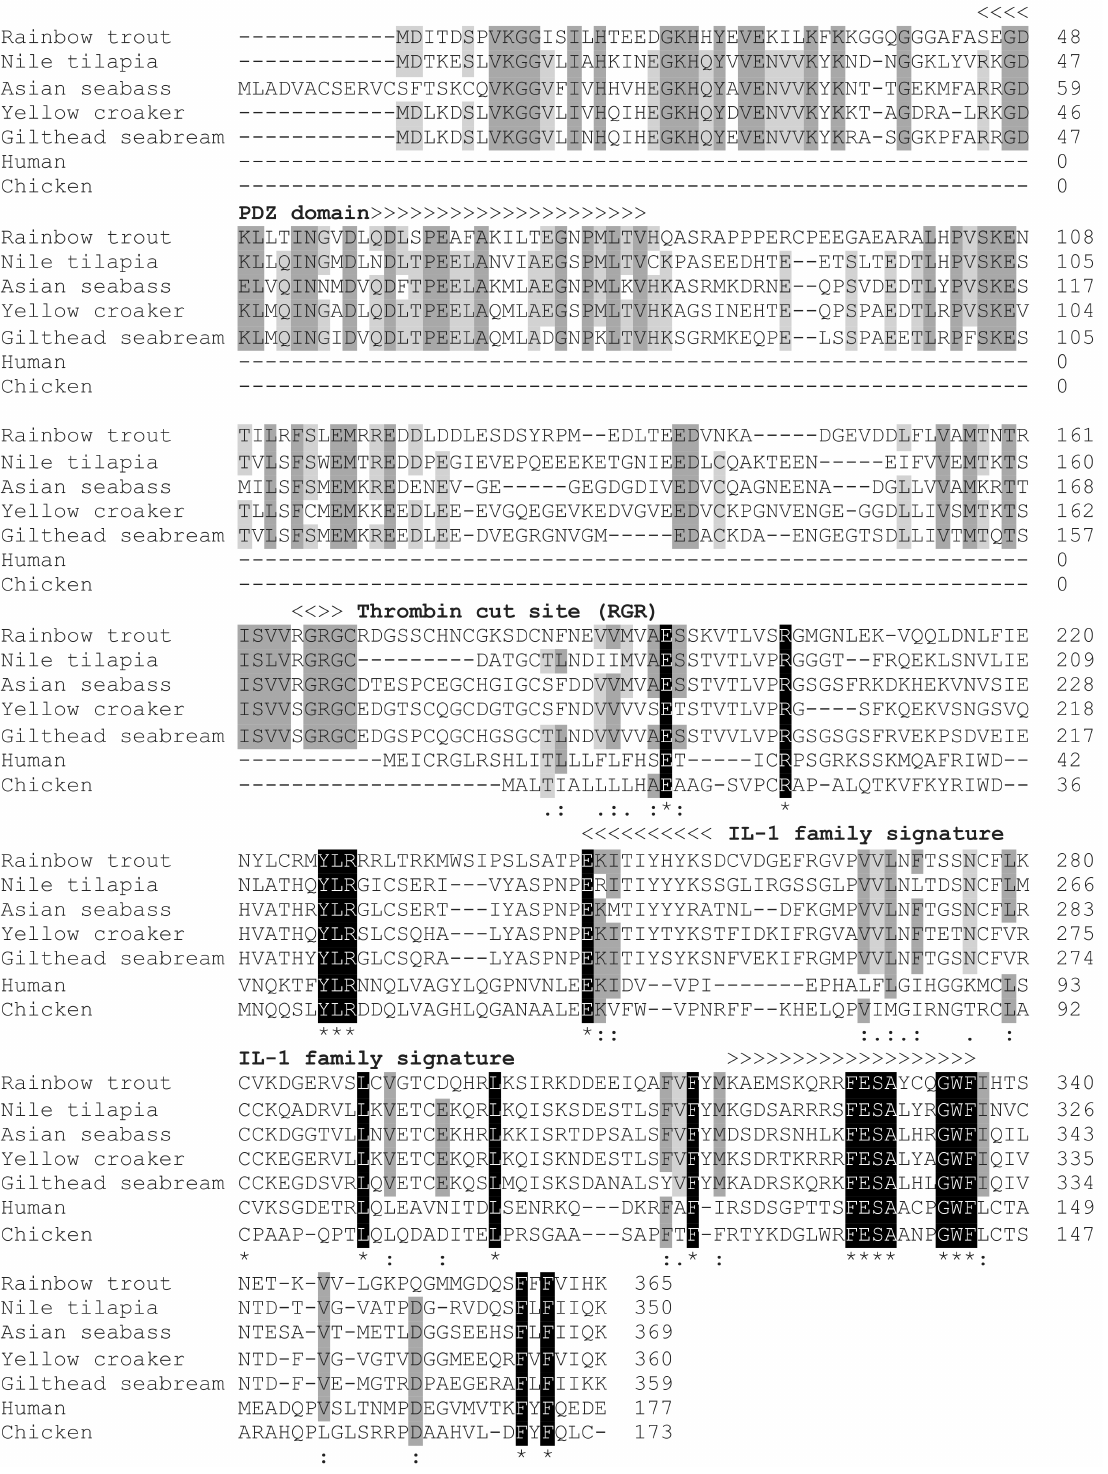
Figure 2. Multiple alignments between the known nIL-1Fm sequences in various vertebrates and the deduced Nile tilapia nIL-1F gene. Asterisks (*) indicate amino acid residues that are identical to those in the Nile tilapia. Dot ( . ) and colon ( : ) indicate positions of similar amino acid residues that are similar sequence. Dashes ( - ) indicate gaps introduced for maximal